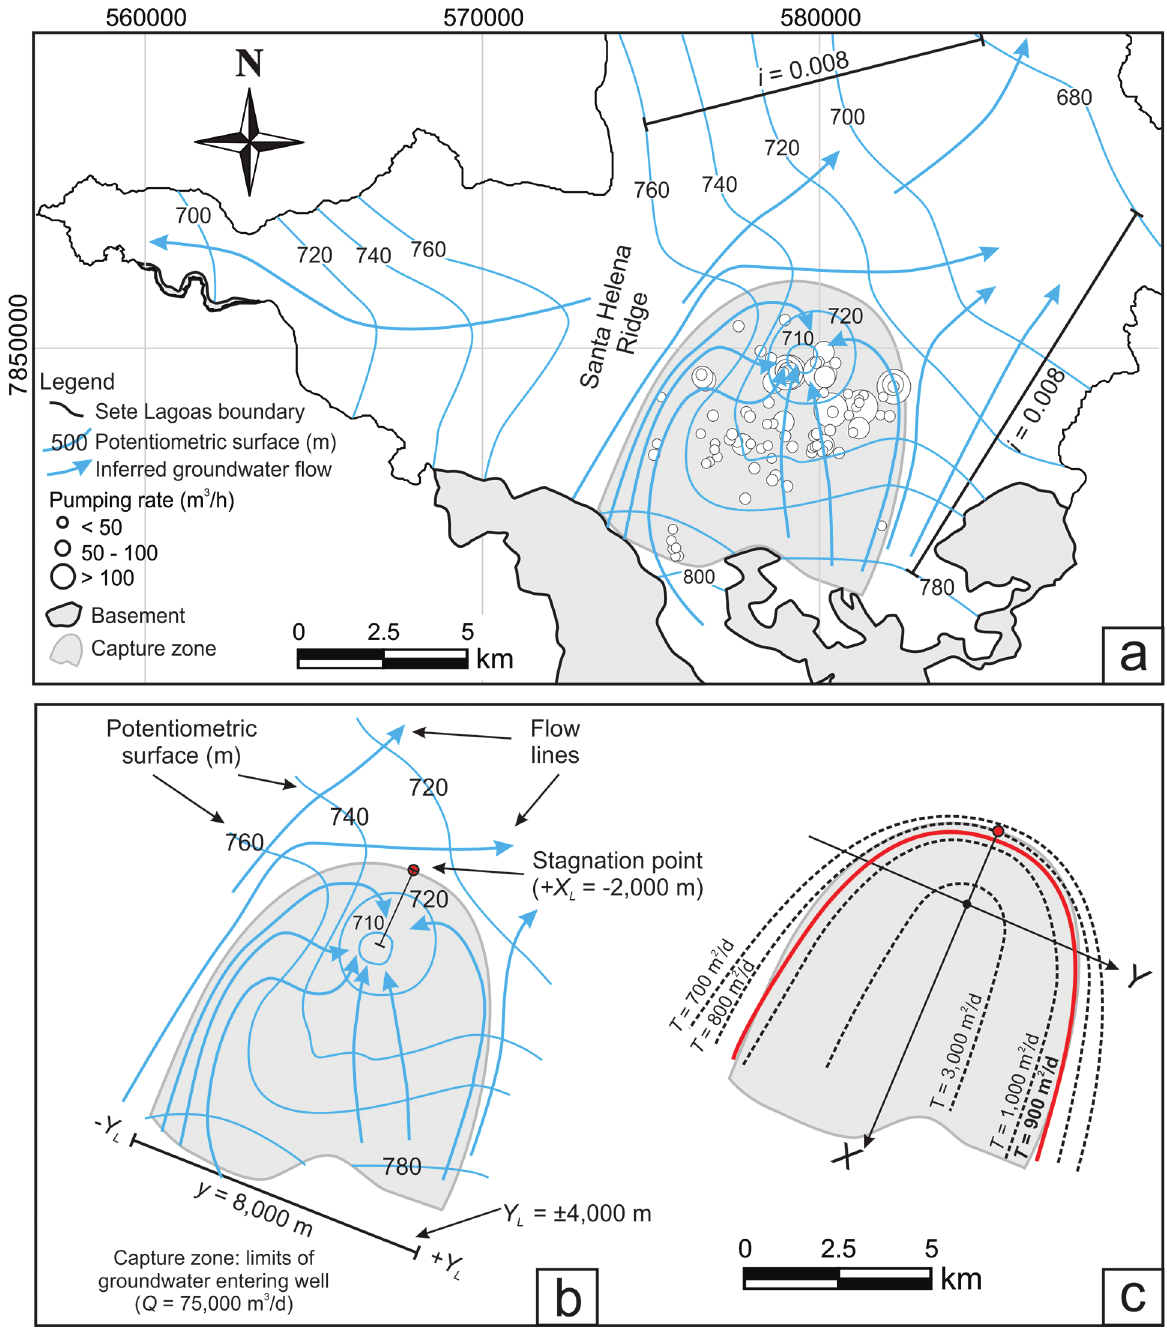
Figure 3 – Potentiometric surface map, where a capture zone is recognized (a) . Description of the capture zone model shape, its parameters and respective variables (b) . Comparison between the best-fit empirical capture zone curves (red solid and dashed black lines) and the potentiometric surface capture zone (grey area) assuming variations of transmissivities (c) (modified from Galvão et al. Thus, different x and y values can be calculated by adjusting only intervals of T values from the equation (5), and then different empirical capture zones can be generated in a Cartesian coordinate system